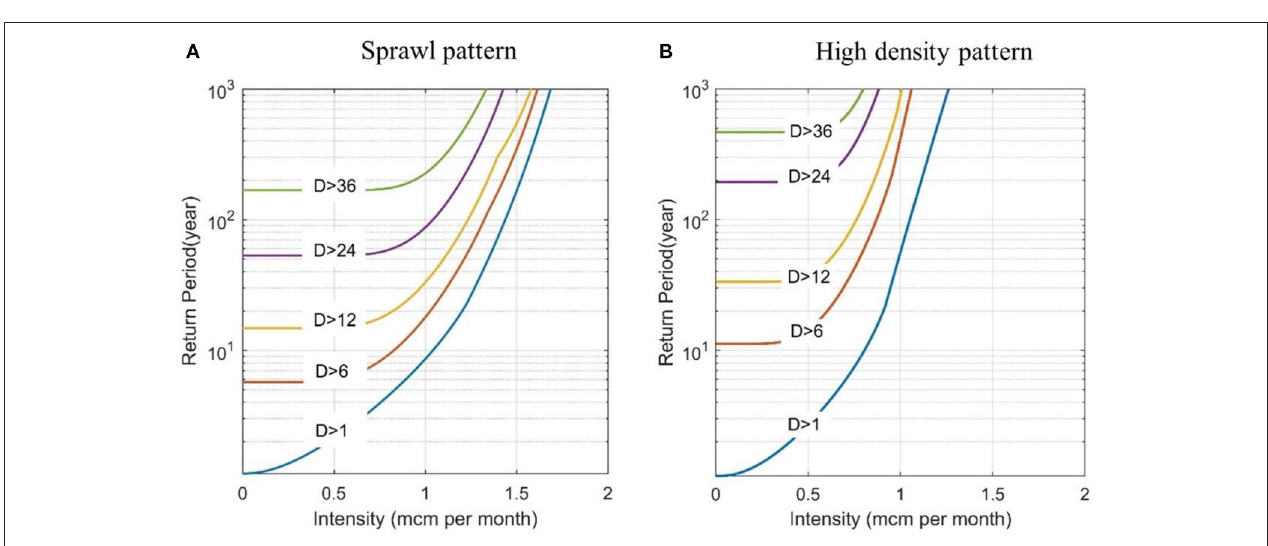
FIGURE 4 | Intensity-duration-frequency (IDF) curves for future conditions under (A) Sprawl patterns and (B) High-density pattern for duration (D) greater than 1, 6, 12, 24, and 36 months.